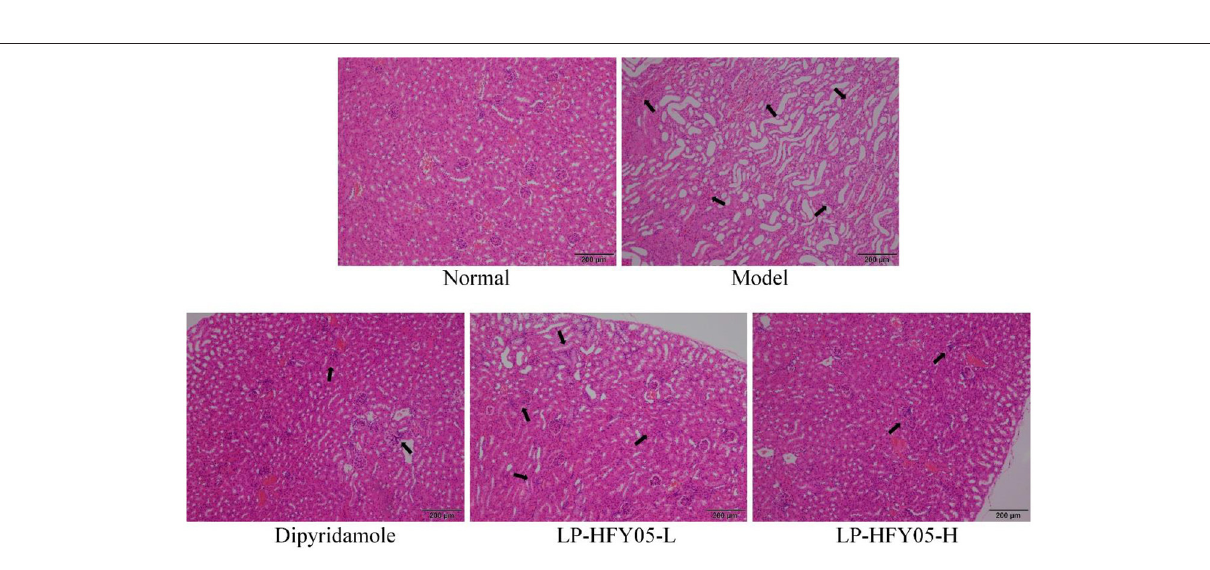
Frontiers in Nutrition |